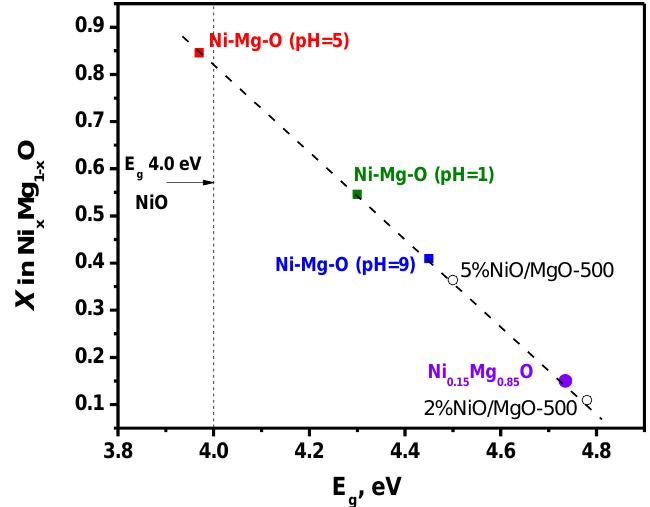
Figure 5. The values of the energy-gap width and corresponding Ni content estimated for the Ni x Mg 1 − x O particles.